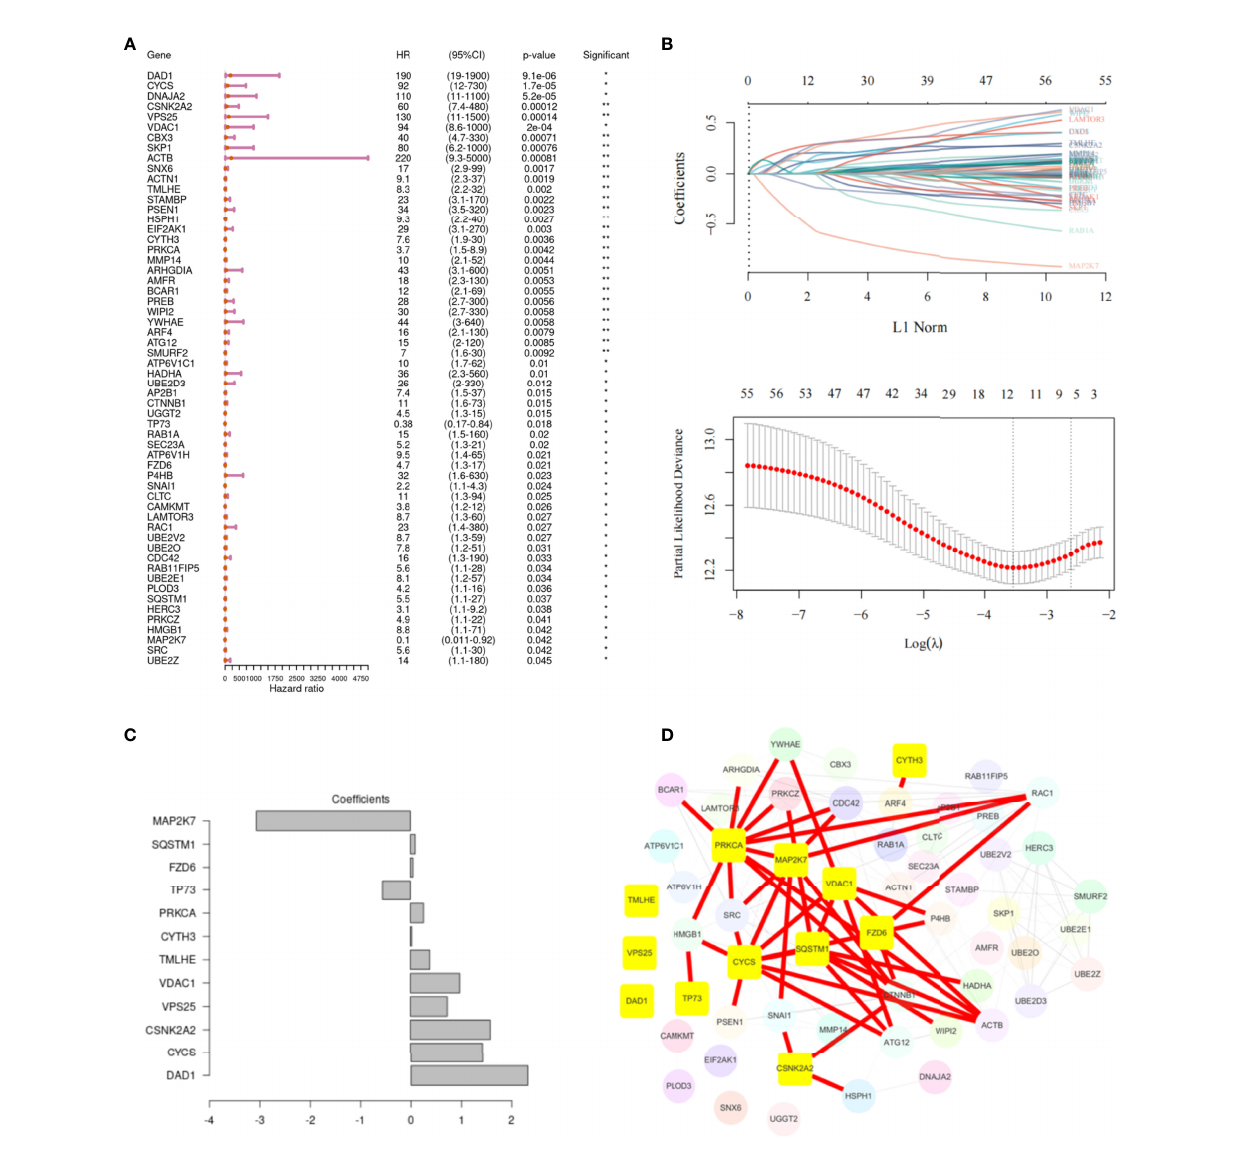
FIGURE 4 | Screening of the key genes related to m6A in head and neck squamous cell carcinoma (HNSCC). (A) Univariate Cox regression analysis, showing 58 m6A regulator-related genes associated with the survival of patients with HNSCC. (B) The 12 m6A regulator-related genes are most relevant to the survival status, as identi fi ed by screening with the Lasso – Cox regression. The partial likelihood deviance is shown against log (Lambda). A vertical line is drawn at the value fi tting the tenfold cross-validation. (C) The Lasso – Cox regression coef fi cients for the 12 identi fi ed genes. (D) PPI network of 58 genes, highlighting the top 12